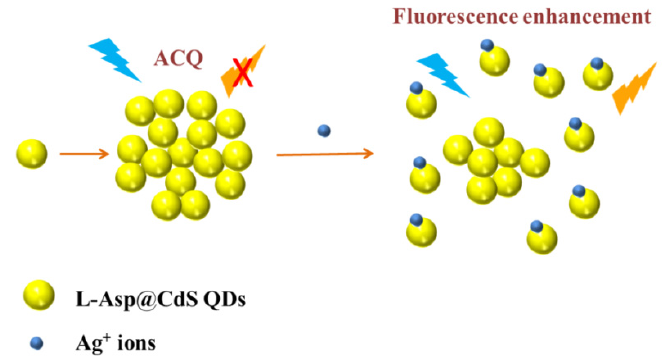
Figure 8. Schematic diagram for L-Asp@CdS QDs fluorescence enhancement by Ag + ions.